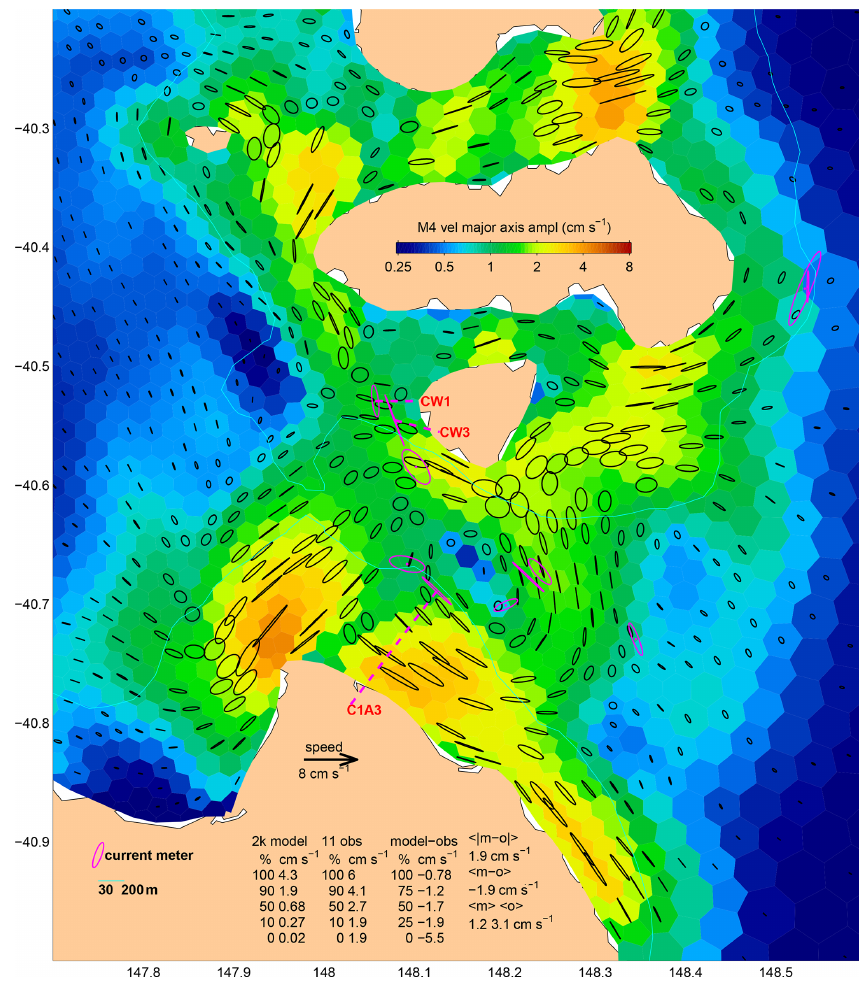
Figure 14. Amplitude of the M4 major axis velocity for the Banks Strait region; otherwise like Fig.